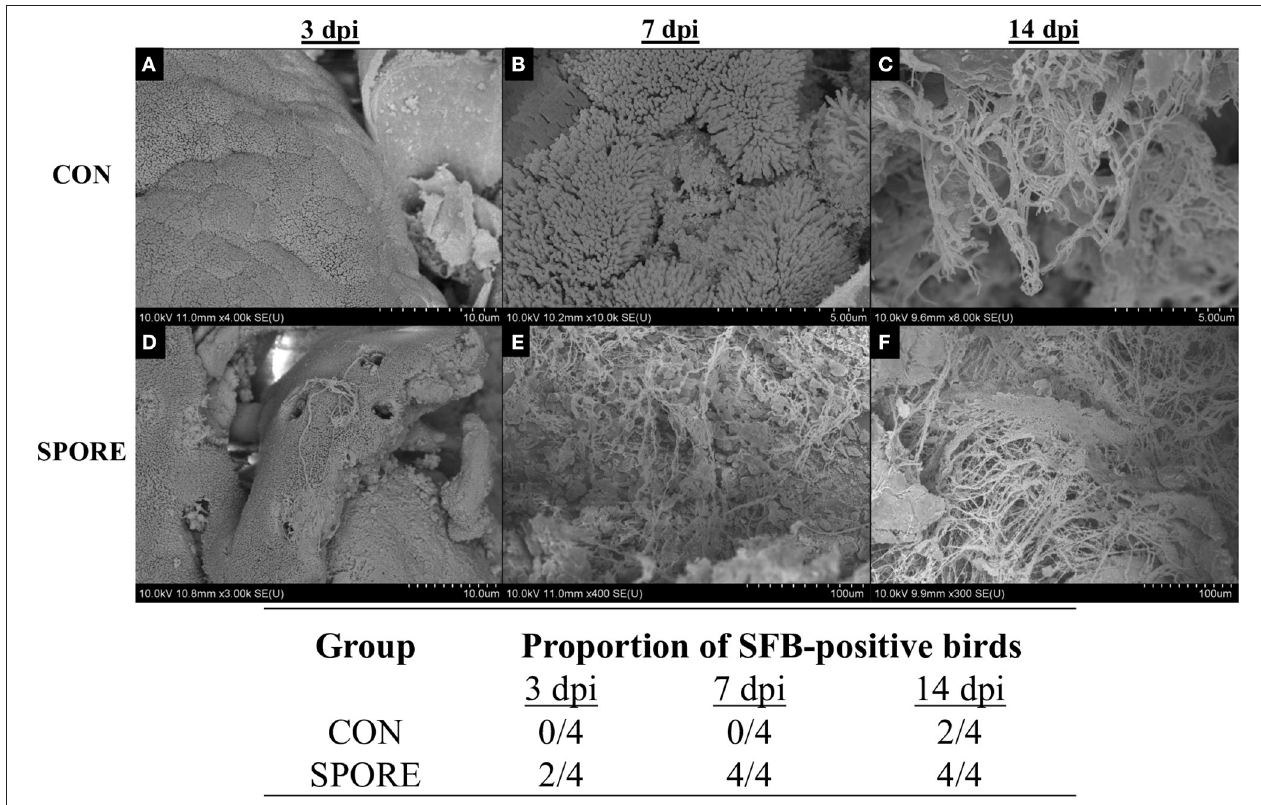
FIGURE 3 | SEM detection of SFB in the distal ileum. SEM images were taken for CON (A–C) and SPORE (D–F) birds at multiple days post-inoculation (dpi) to track SFB colonization over time. (A,D) , 3 dpi. (B,E) , 7 dpi. (C,F) , 14 dpi. In addition, a table summarizing the total findings is provided.